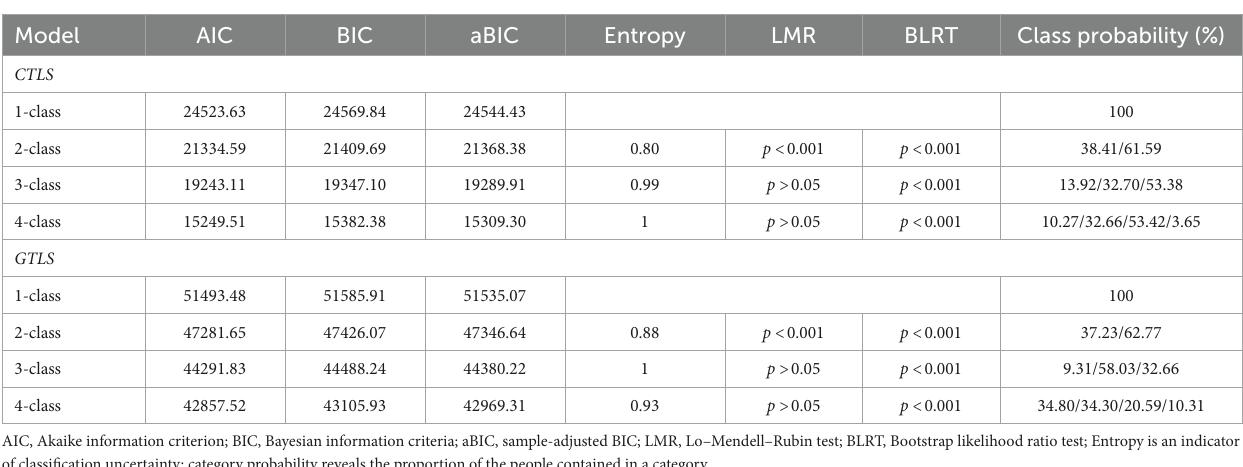
TABLE 3 Fit statistics and class probability for LPA.